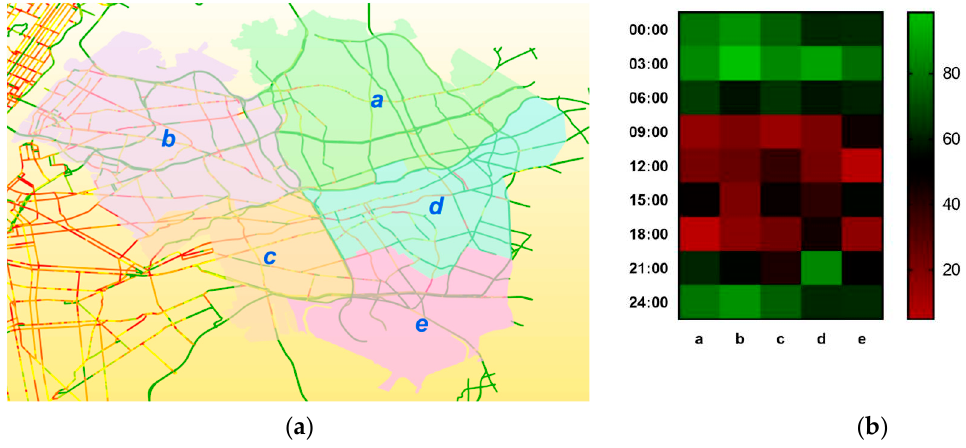
Figure 8. Visualization of network-wide traffic flow prediction results: ( a ) prediction results of different blocks divided by Zone with the clustering method; ( b ) the speed heatmap of each block.